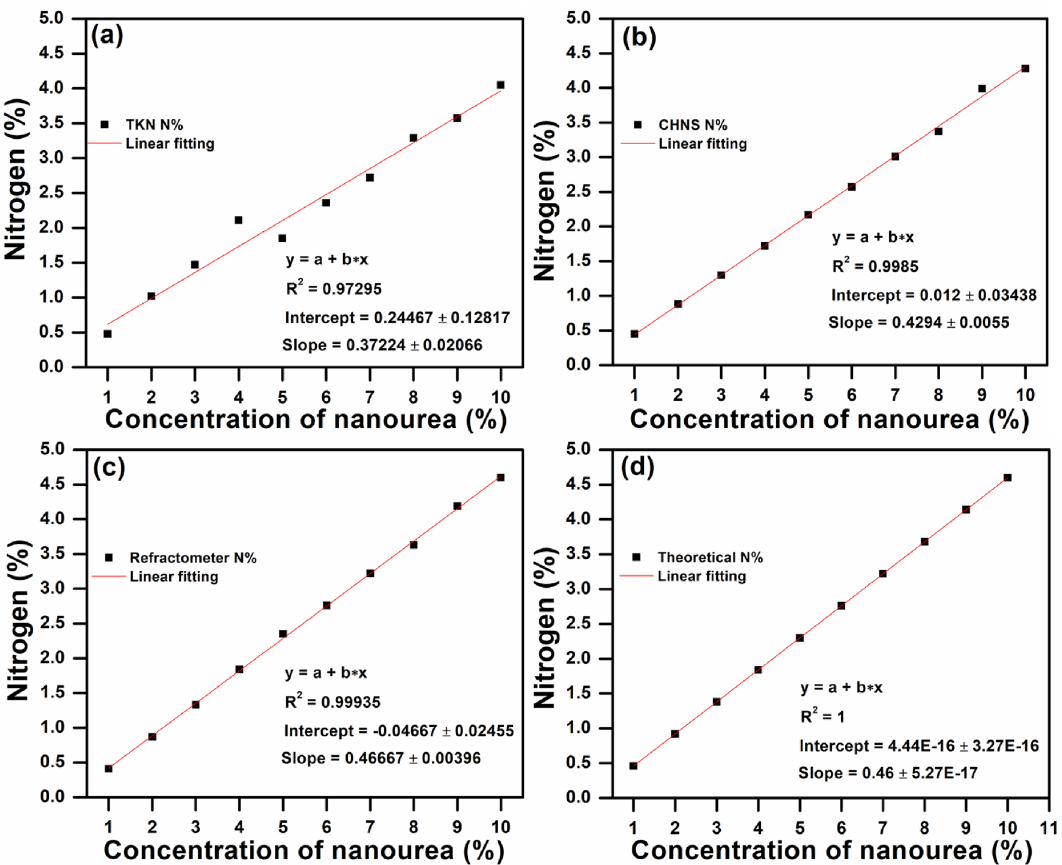
Figure 2. Linear fitting between nitrogen (%) and different concentration of nano urea (1–10%) for ( a ) TKN, ( b ) CHNS ( c ) refractometer, and ( d ) theoretical N%. (Refractometer showed R 2 value is close to the theoretical value for the analysis of nano